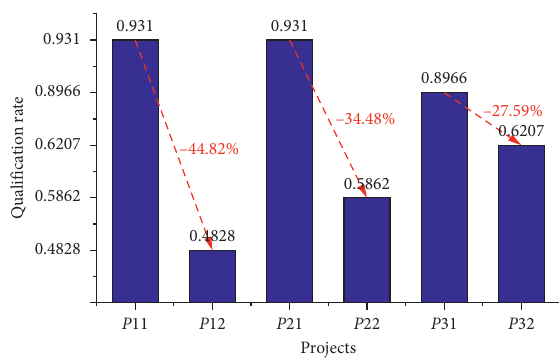
Figure 1: Experimental results for the grouting